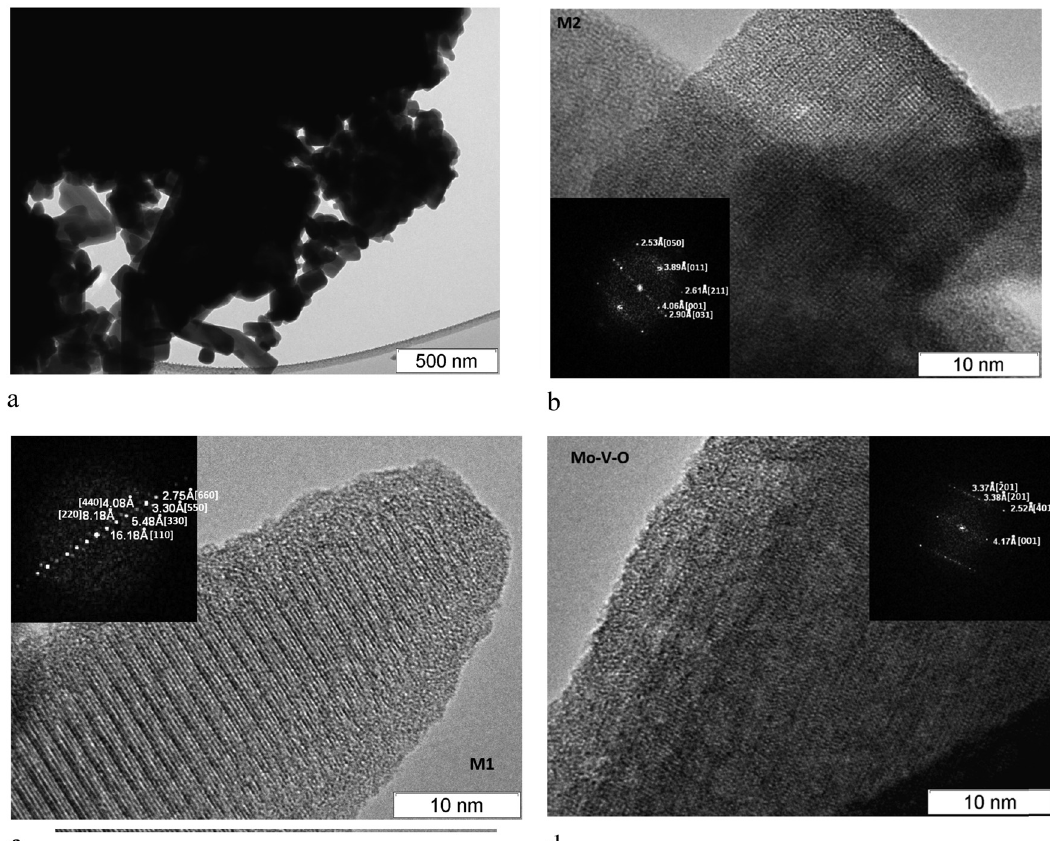
Figure 4: TEM image morphology ( a ) , HRTEM and FFT images with labeled observed interplanar distances and corresponding indexes for phases M2 ( b ) , M1 ( c ) , and Mo – V – O ( d ) of MoVTeNbO catalyst before